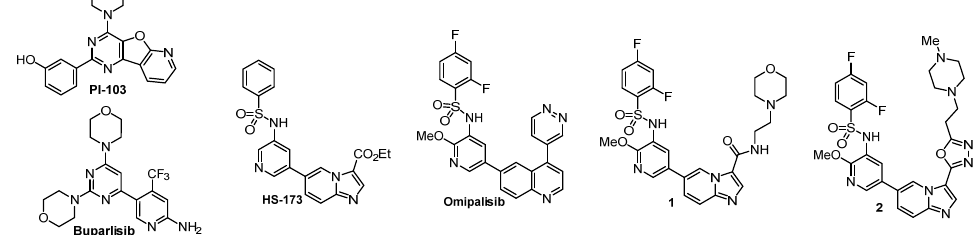
Figure 1. The chemical structures of some representative PI3K/mTOR dual